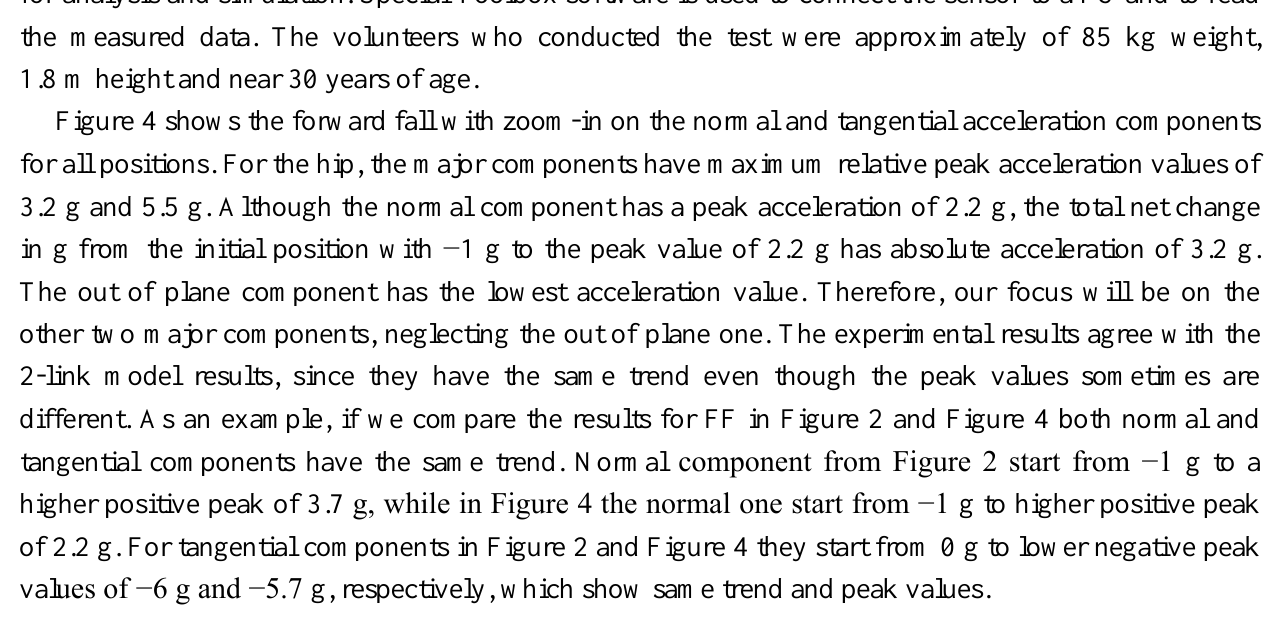
Figure 4. Samples of measured fall accelerations for the hip, chest and head